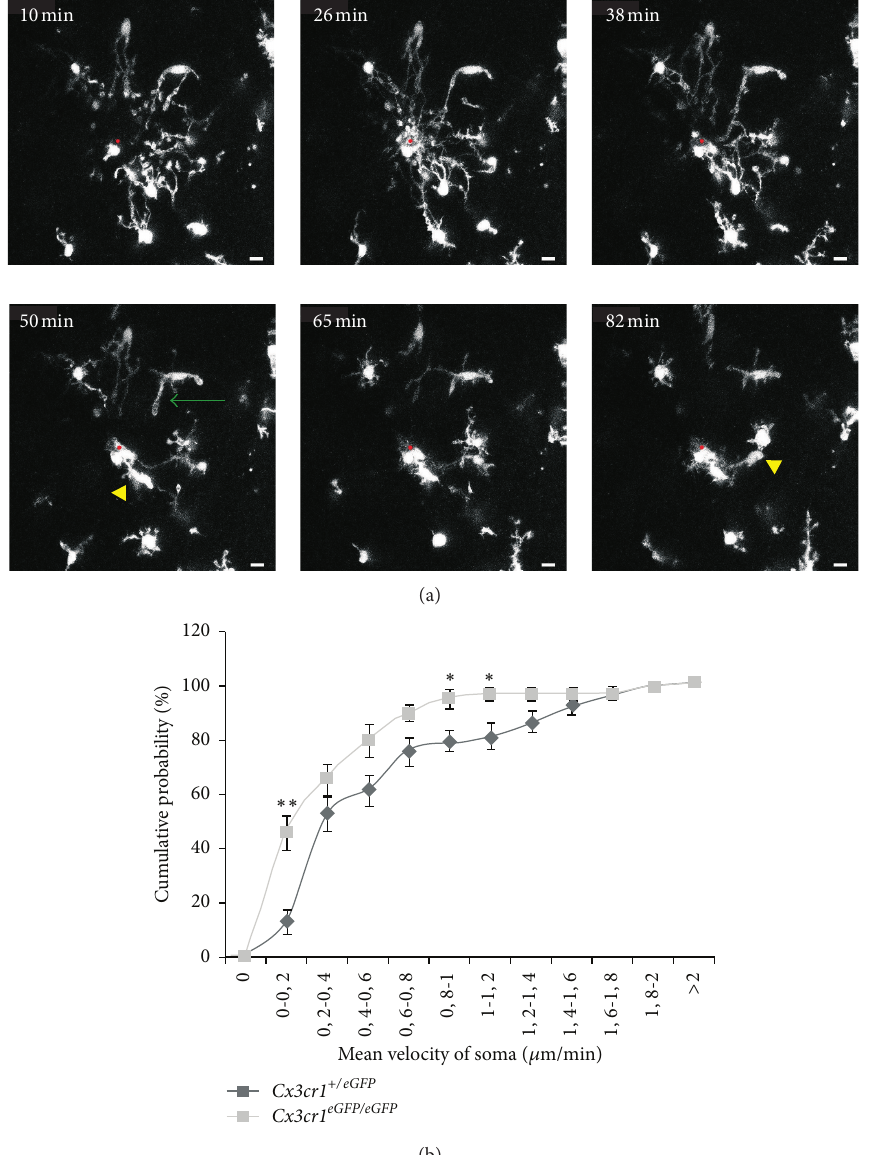
Figure 4: Impaired microglia motility in developing CX3CR1 deficient mice. (a) Two-photon images in an acute slice of a P7 Cx3cr1 +/eGFP mouse showing the dynamics of microglial processes and soma after the insertion (at time 0 min, not shown) of a pipette (red dot) containing 2-MeSADP (100 𝜇 M). Yellow arrowheads indicate the soma of 2 microglial cells moving toward the pipette. Green arrow indicates a retracting process. Calibration bar is 10 𝜇 m. (b) Comparison of the mean velocity of microglia soma toward the 2-MeSADP-containing pipette